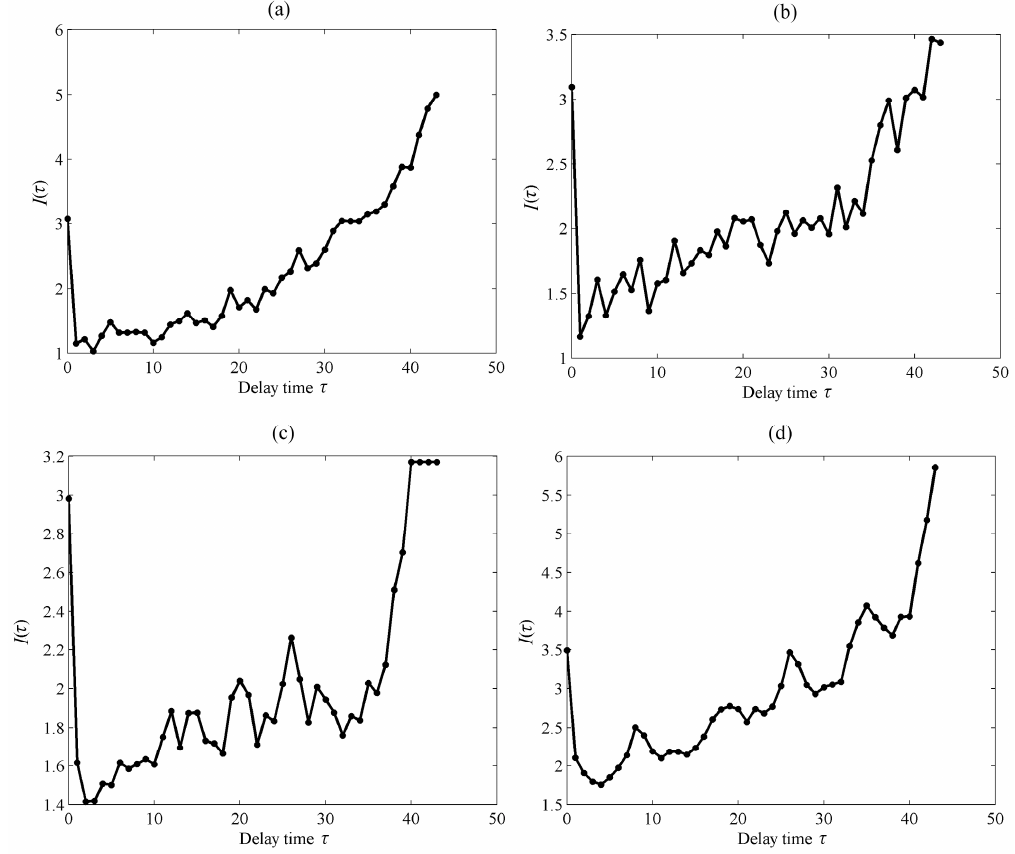
Figure 3 indicates the mutual information )( Shangjingyou